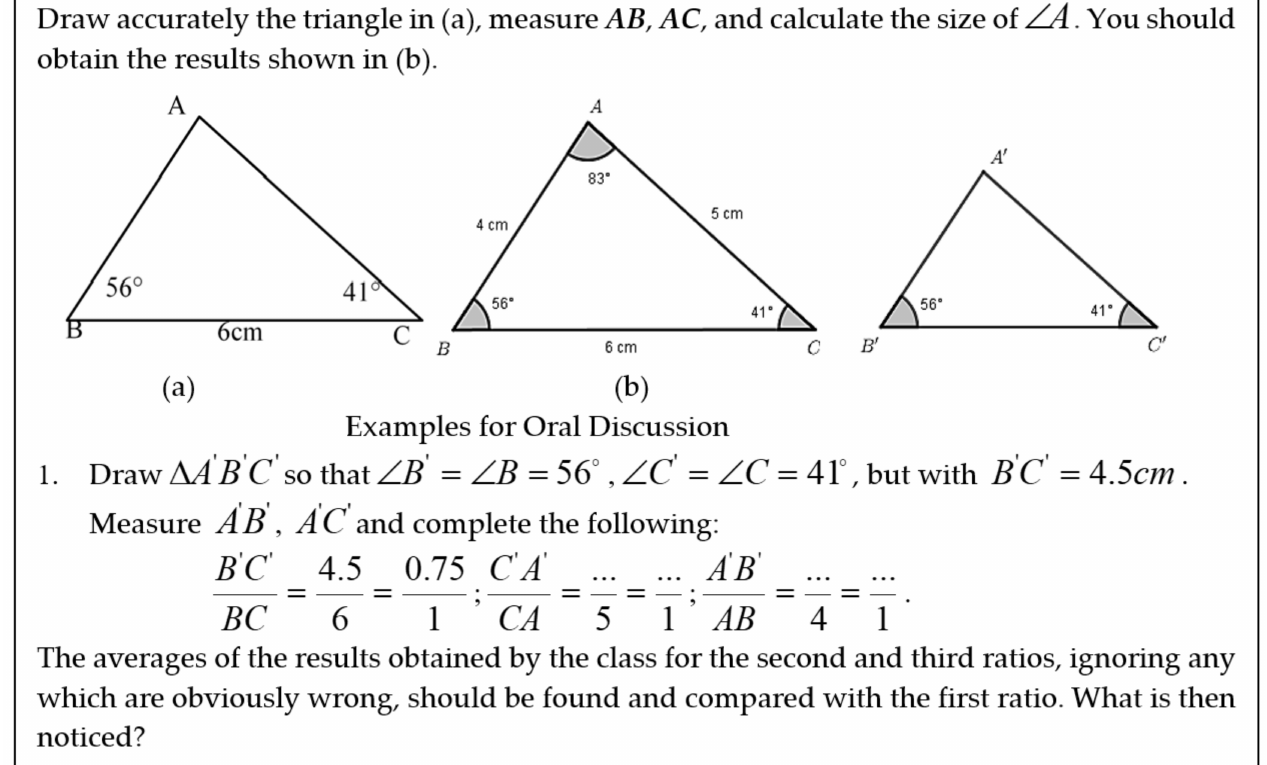
Figure 5. Oral discussion in textbook I [42] (p.